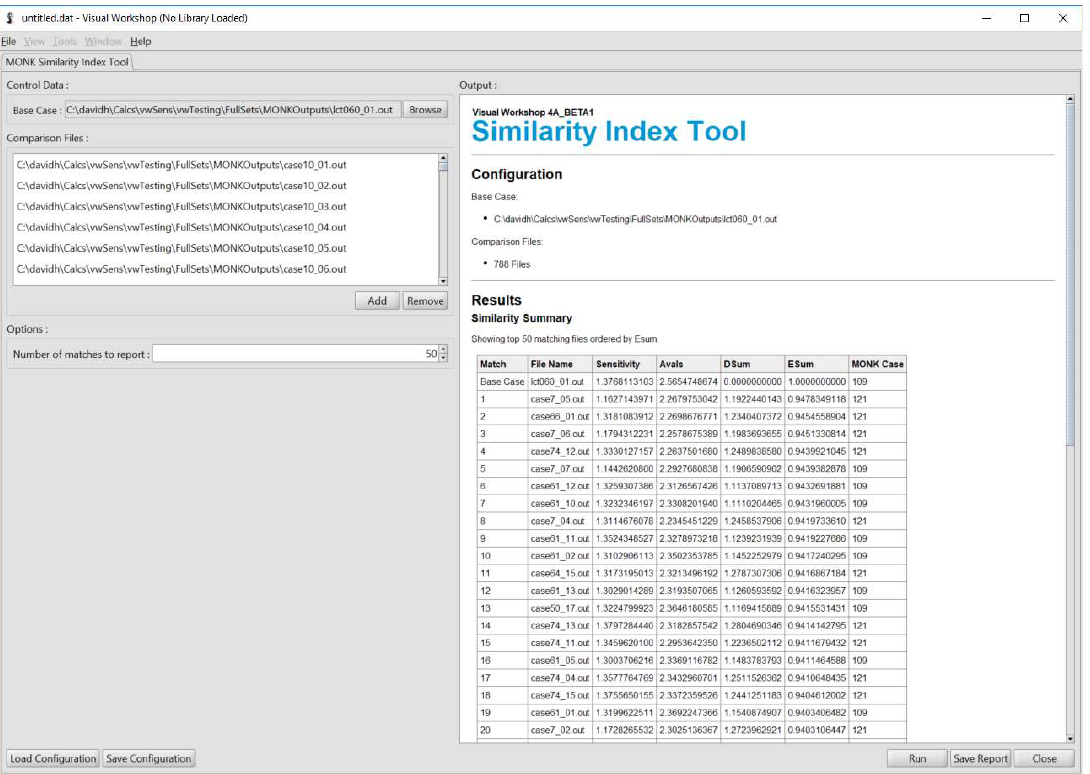
Figure 5. Screen Shot from the Similarity Index